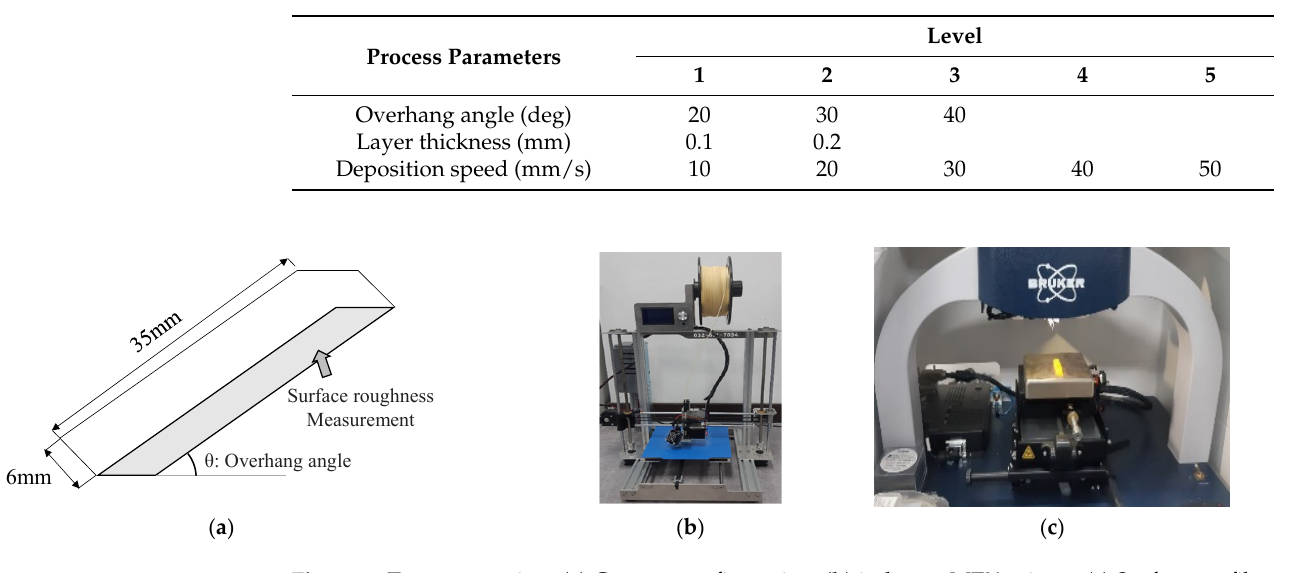
Figure 6. Test preparation: ( a ) Coupon configuration; ( b ) in-house MEX printer; ( c ) Surface profiler. Table 4. Preset process parameters for coupon fabrication. Table 3. Level of process parameters for parametric study.